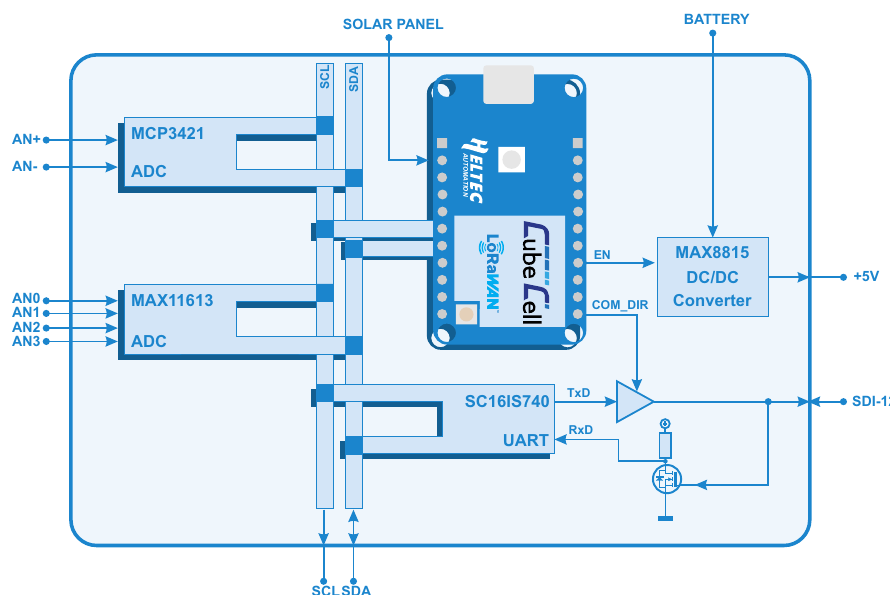
Figure 3. LoRaWAN node simplified schematic.